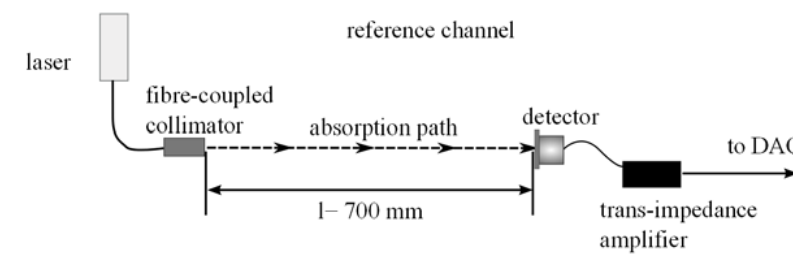
Figure 2. Static TDLAS spectrometer setup for reference measurements of the H 2 O concentration.